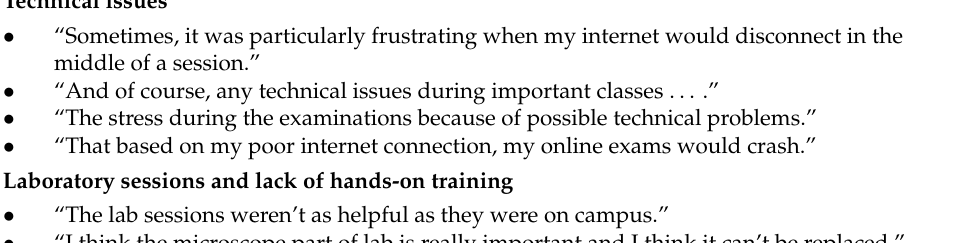
Table 3. Selection of comments from our students regarding the challenges faced while attending the virtual classes during the COVID-19